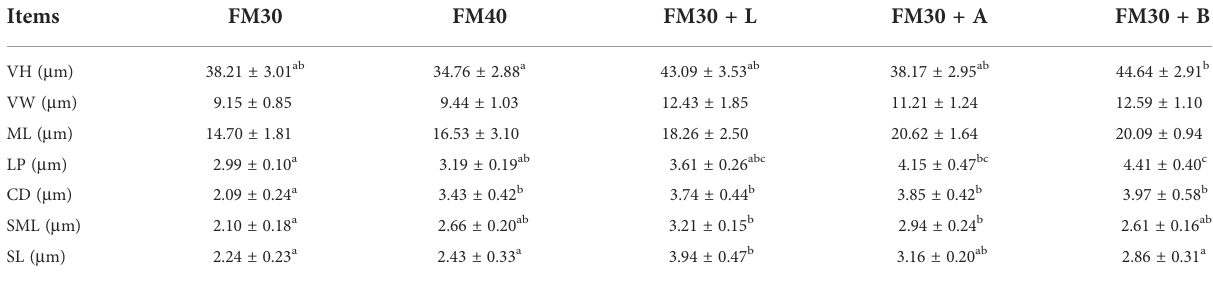
TABLE 7 Histomorphometry of the intestine of M. salmoides fed different experimental diets.